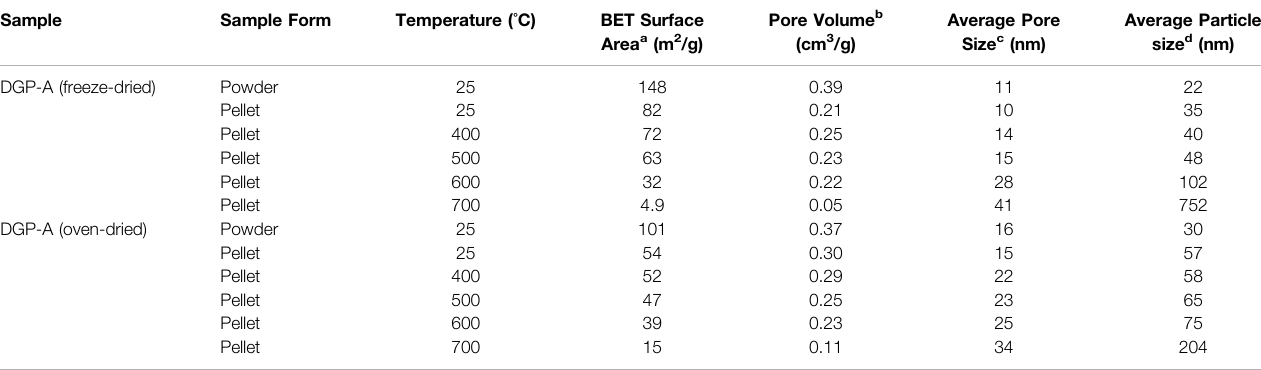
TABLE 2 | Pore characteristics of selected sample pellets subjected to various heat treatments.